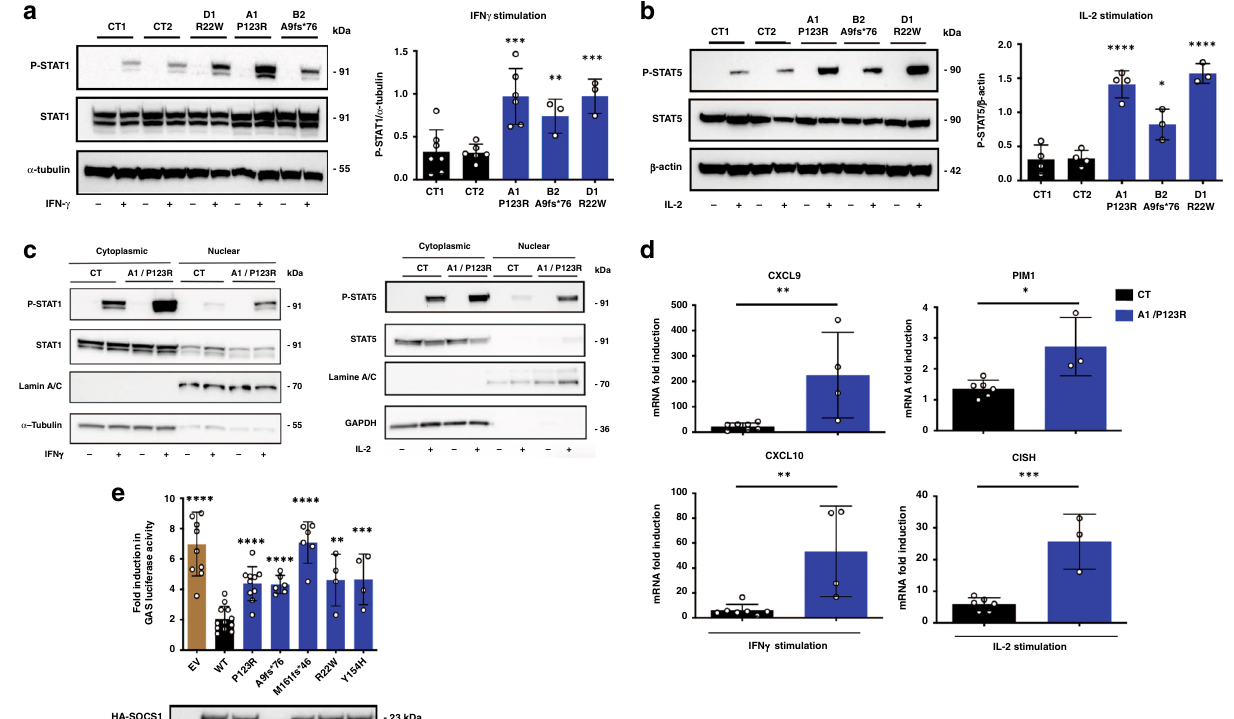
Fig. 2 SOCS1 mutations result in uncontrolled STAT pathways activation. a , b Left: Western blots (WB) of patients (A1, B2, and D1) and healthy controls (CT) derived EBV-B cells stimulated with IFN- γ (10 3 IU/ml for 1 h) ( a ) or IL-2 (10 4 IU/ml for 2 h) ( b ). Lysates were incubated with an antibody against tyrosine-phosphorylated STAT (P-STAT) or against total STAT, as indicated. Right: densitometric quanti fi cation of the phospho-STAT/ α -tubulin or β -actin ratio upon stimulation. a, b Data are representative of n = 3 (patients B2 and D1), n = 4 (A1, IL-2 stimulation), and n = 6 (A1, IFN γ stimulation) independent experiments. Statistics (versus CT2): IFN γ stimulation, A1 p = 0.0008, B1 p = 0.0029, D1 p = 0.0002; IL-2 stimulation, A1 p < 0.0001, B1 p = 0.0118, D1 p < 0.0001. c The nuclear and cytoplasmic fractions of EBV-B cells from a control (CT) and from patient A1 after stimulation with IFN- γ for 1 h (left) or with IL-2 for 2 h (right) were tested by WB for the presence of P-STAT1 and P-STAT5, respectively. Anti-lamin A/C and anti- α -tubulin antibodies were used to normalize the amount of nuclear and cytoplasmic proteins. Data are representative of two independent experiments. d Real-time quantitative RT-PCR assays of CXCL9 and CXCL10 expression 6 h after stimulation with IFN- γ (left), and assays of CISH and PIM1 expression 6 h after stimulation with IL-2 (right) in EBV-B cells from a CT and from patient A1. Results represent the fold-increased expression between stimulated and unstimulated states and are normalized to endogeneous GAPDH. Data are representative of n = 3 (IL-2 stimulation) and n = 4 (IFN γ stimulation) independent experiments performed in triplicate. Statistics: IFN γ stimulation, CXCL9 p = 0.0094, CXCL10 p = 0.0063; IL-2 stimulation, PIM1 p = 0.0105, CISH p = 0.0008. e Fire fl y luciferase activity in HEK293T cells transiently transfected with a gamma-activated sequence-driven IFN- γ reporter plasmid (GAS) and expression plasmids for WT or mutant SOCS1 proteins, and then stimulated with IFN- γ for 24 h. The results correspond to the fold-difference between the stimulated state and the transfected plasmids was con fi rmed by immunoblotting the cell lysates (below, one representative result). Statistics: EV p < 0.0001, P123R p < 0.0001, A9FS*76 p < 0.0001, M161FS*46 p < 0.0001, R22W p = 0.0011, Y154H p = 0.0009. a , b , d , e Two-tailed p values were determined in an unpaired t est. Data indicate mean with SD. * P ≤ 0.05; ** P ≤ 0.01; *** P ≤ 0.001; **** P ≤